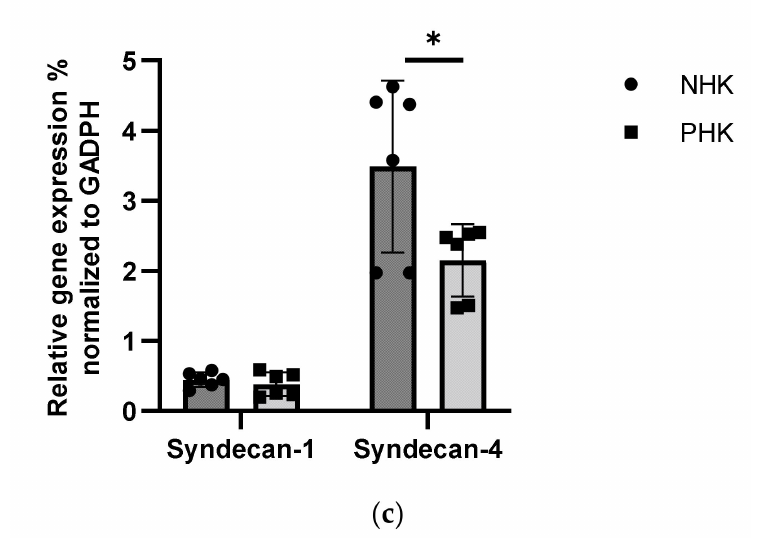
Figure 2. ( a ) Proliferation of normal human (NHK) and psoriatic keratinocytes (PHK) over 24 h. Four donors and five replicates per condition. Proliferation determined by MTT analysis. ( b ) Quantitative Real-Time PCR (QPCR) analysis of keratins (K6, K10, and K14) gene expression normalized to GAPDH in keratinocytes from lesional skin from 3 psoriatic donors vs. 3 healthy donors, plated on culture dishes. ( c ) QPCR analysis of syndecan-1 and -4 gene expression normalized to GAPDH in keratinocytes from lesional skin from 3 psoriatic donors vs. 3 healthy donors, plated on culture dishes. Experiments c and d were done in duplicates per donor, Mean ± (standard deviation) SD, * p < 0.05, **** p <